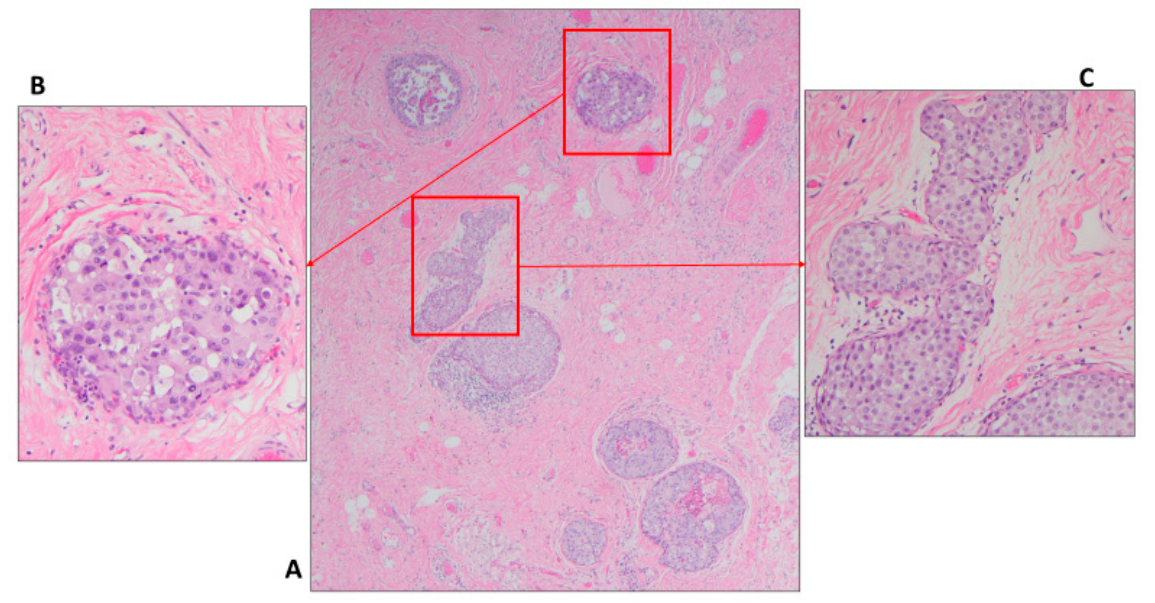
Figure 6. Heterogeneity of nuclear grade in the same section different ducts; ( A ) DCIS involving few ducts (H&E 4×); ( B ) duct with HG-DCIS (H&E 40×); ( C ) duct with IG-DCIS solid and cribriform pattern (H&E 40×).